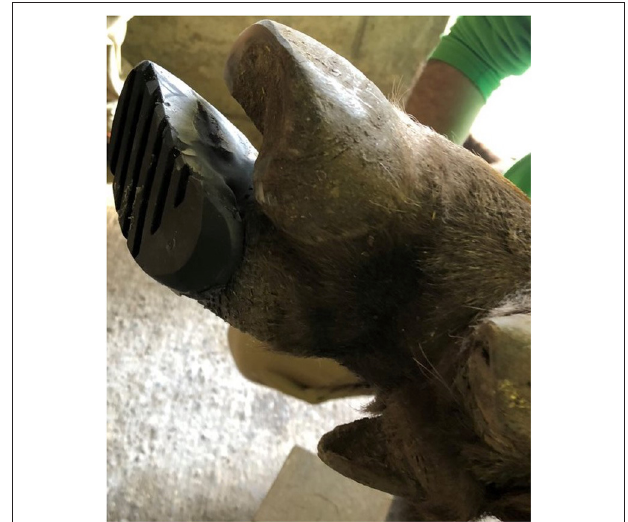
FIGURE 3 | Orthopedic polyurethane claw block fixed to the healthy partner claw for treatment of a multifragmentary fracture of the lateral proximal phalanx of the left hind limb of an adult female European bison ( Bison bonasus ).